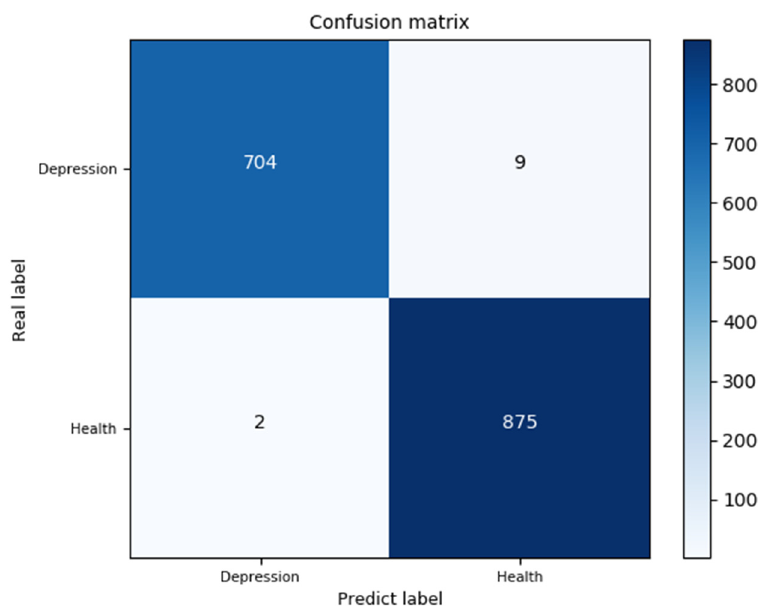
Figure 8. Confusion matrix of the test set.